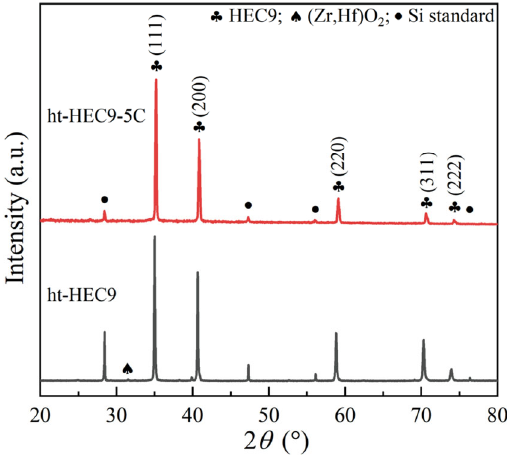
Fig. 3 XRD patterns of the sintered ht-HEC9 and ht-HEC9-5C ceramics.